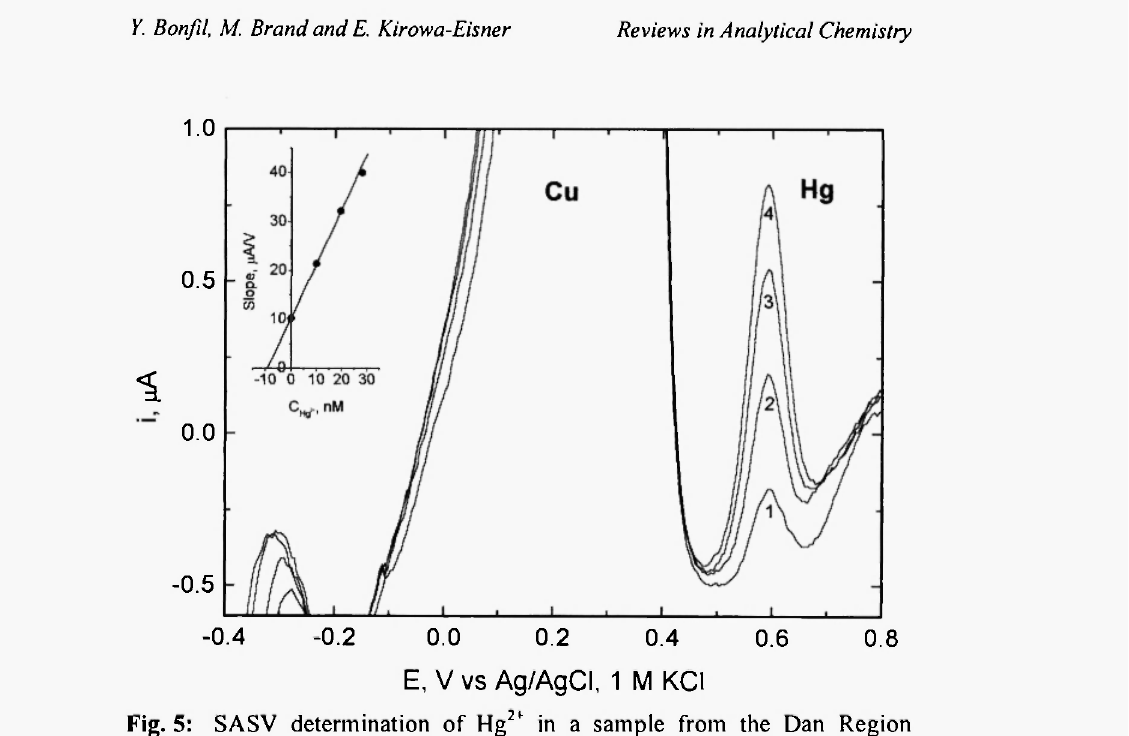
Fig. 5: SASV determination of Hg 2 " in a sample from the Dan Region Wastewater Institute, without removal of oxygen and using the method of standard additions. The sample was pretreated according to section 2.8. (I) 1.00 mL of the digested sample (diluted by a factor of two during the digestion) inserted into 4.00 mL supporting electrolyte (10 m Μ NaCl, 10 mM HNO,). (2) - (4) standard additions of 50 μί, 1.00 μΜ Hg 2+ . E dep = -.4 V; t dep = 30 s; all other conditions as in Fig.